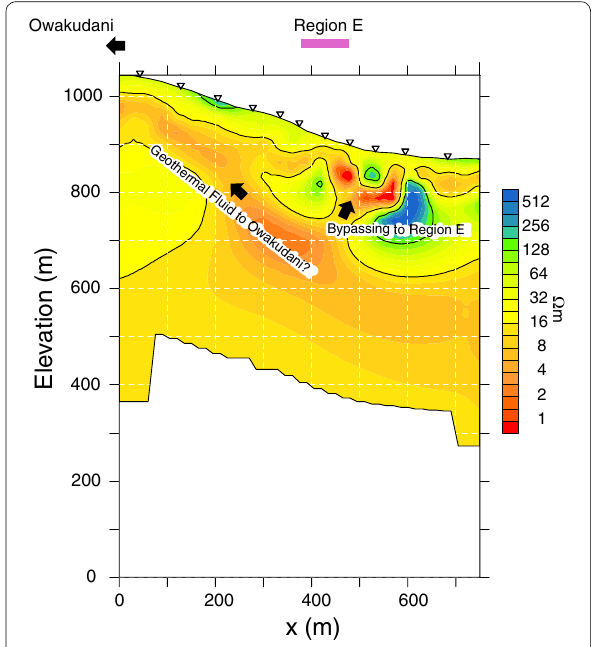
Fig. 4 Cross-sectional structure of resistivity of north Owakudani through Region E observed in 2014. The surface projection of the cross section is shown as Section K in Fig. 2 (Courtesy of Waterworks Department, Public Enterprise Agency of Kanagawa